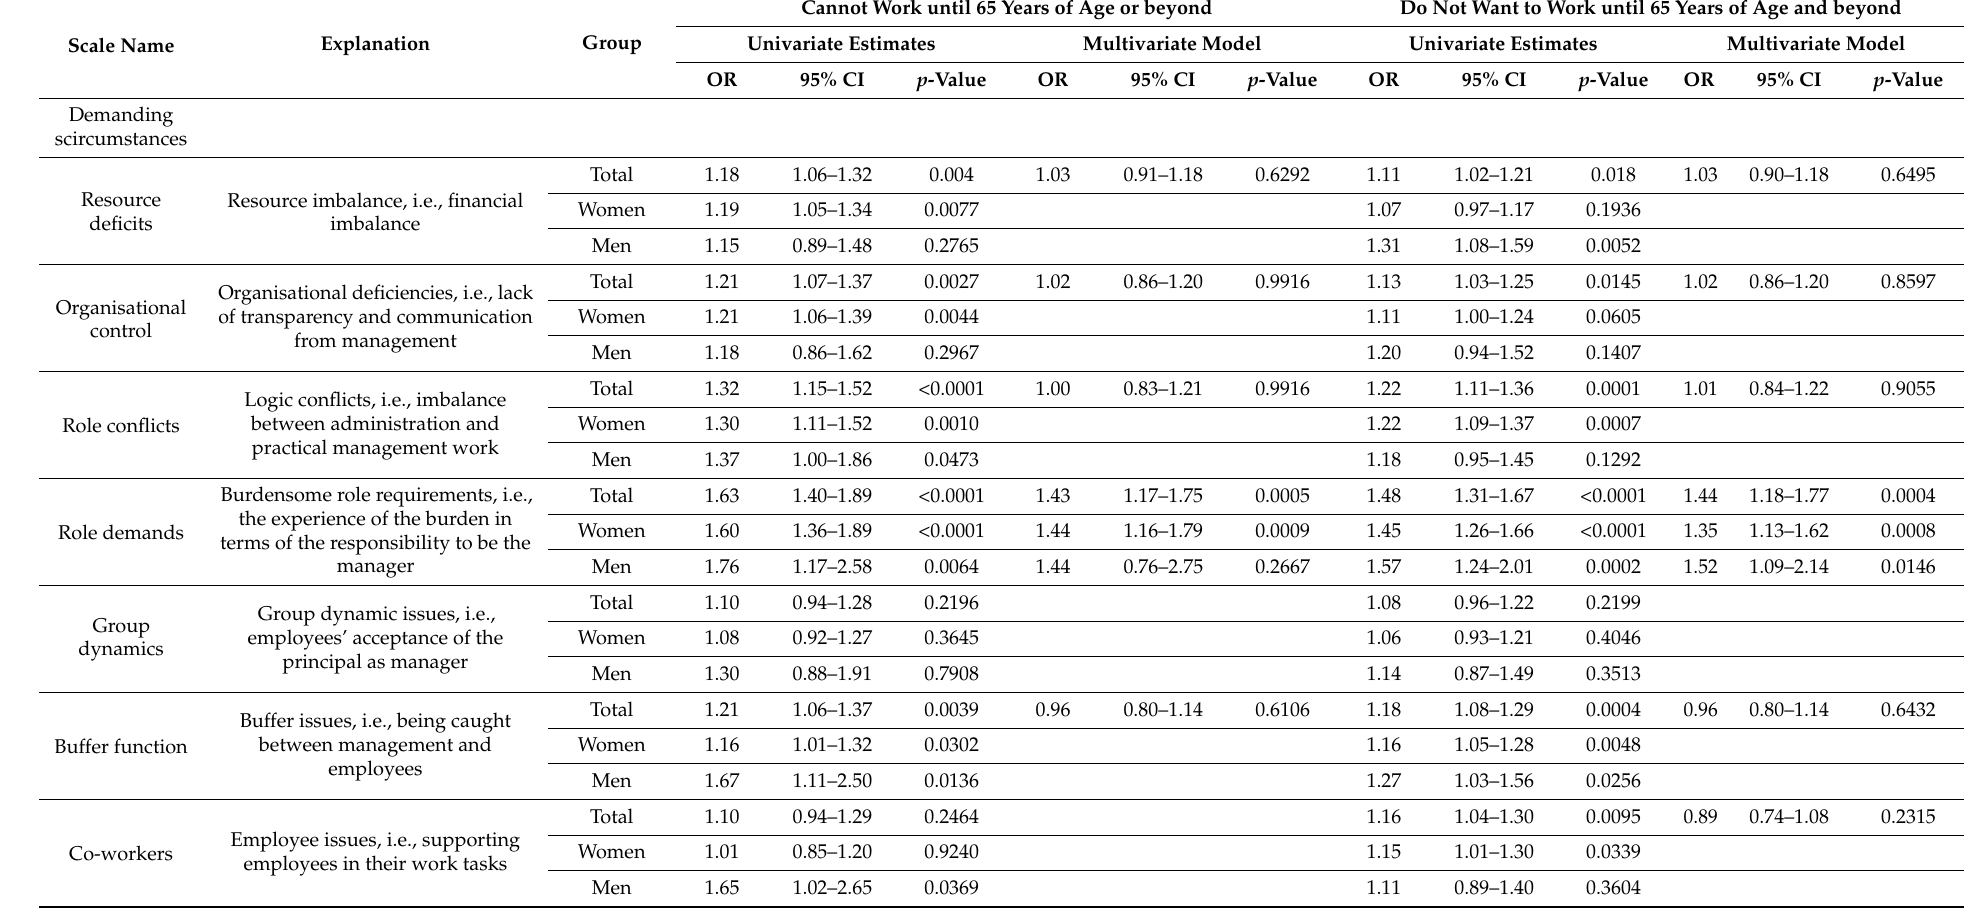
Table 4. Univariate and multivariate estimates from multiple binary logistic regression with repeated measurements on school principals’ assessments of whether they “cannot work” or “do not want to work” until 65 years of age and beyond in association with demanding and supporting managerial circumstances (GMSI variables), for the total study population and stratified by sex. The results are presented as odds ratios (ORs) with accompanying 95% confidence intervals (CIs) and p